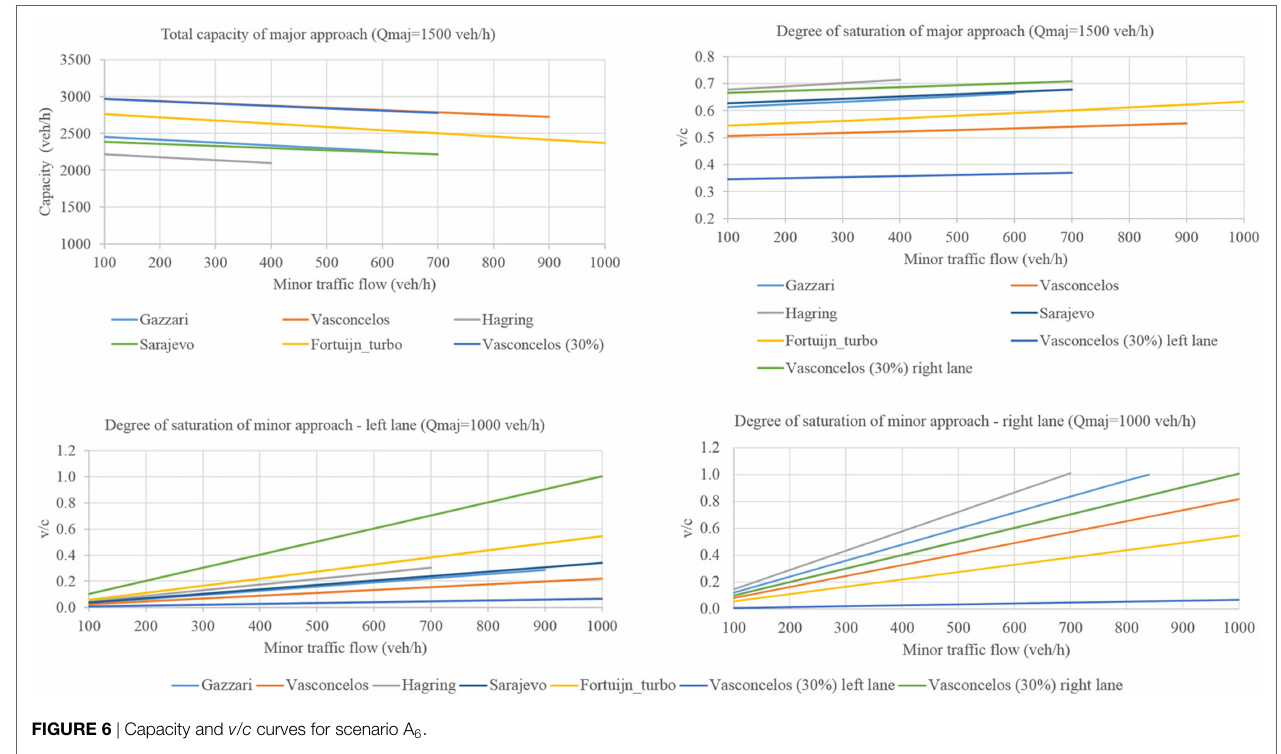
FIGURE 6 | Capacity and v / c curves for scenario A 6 .